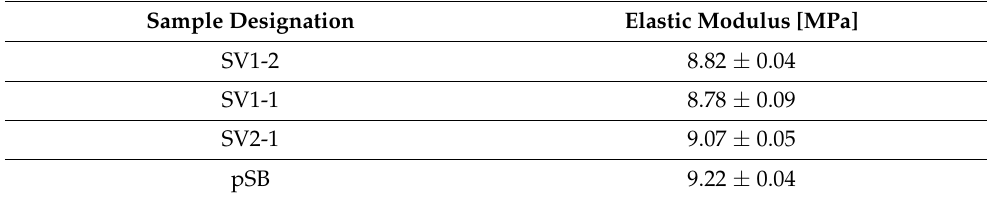
Table 2. Elastic moduli of pVP-co-pSB hydrogels at their ESR in distilled water at room temperature.